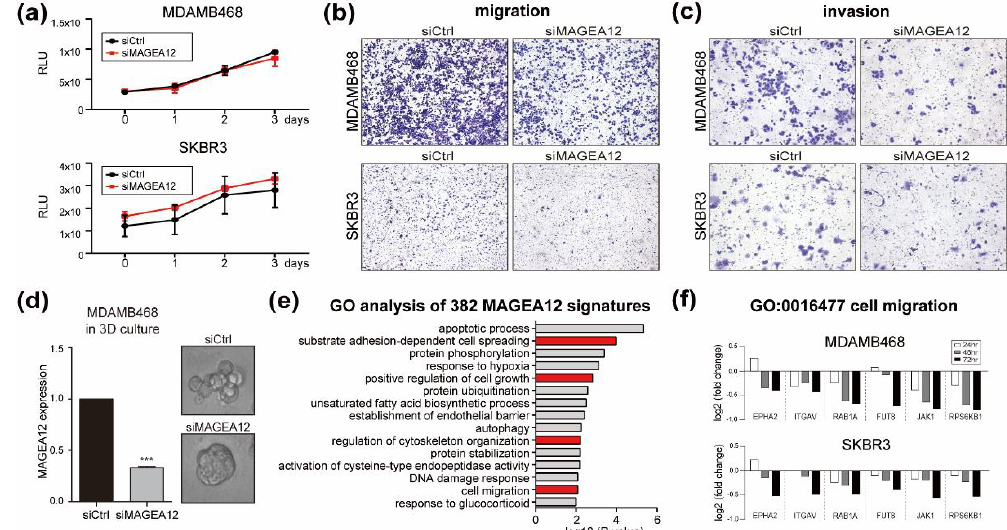
Figure 4. MAGEA12 knockdown suppresses the aggressiveness of breast cancer cells. ( a ) Viability of MDAMB468 and SKBR3 cells after siMAGEA12 treatment. ( b ) Migration and ( c ) invasion of MAGEA12-knockdown MDAMB468 and SKBR3 cells. ( d ) qRT-PCR analysis of siMAGEA12-treated 3D-cultured MDAMB468 cells ( left ) and images of the 3D cultures ( right ). (*** p -value < 0.0001). ( e ) GO enrichment analysis of the biological process terms that were associated most prominently with the 382 signature genes. ( f ) Expression of the GO:0016477 term (cell migration)-annotated genes in MDAMB468 and SKBR3 cells at each time point after MAGEA12-silencing treatment.